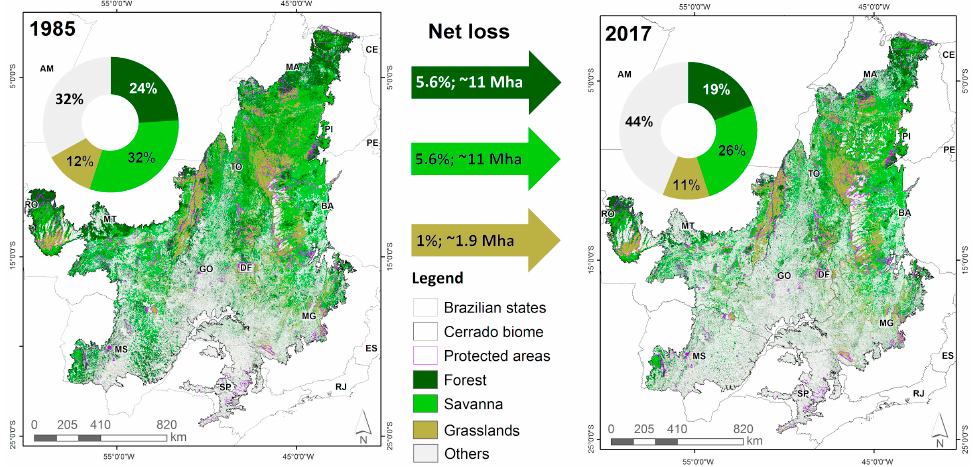
Figure 5. Comparison between the first (1985) and last (2017) maps of the time series, showing the net loss of the three predominant native vegetation classes in relation to the total area of the Brazilian Cerrado. Mha = million hectares.